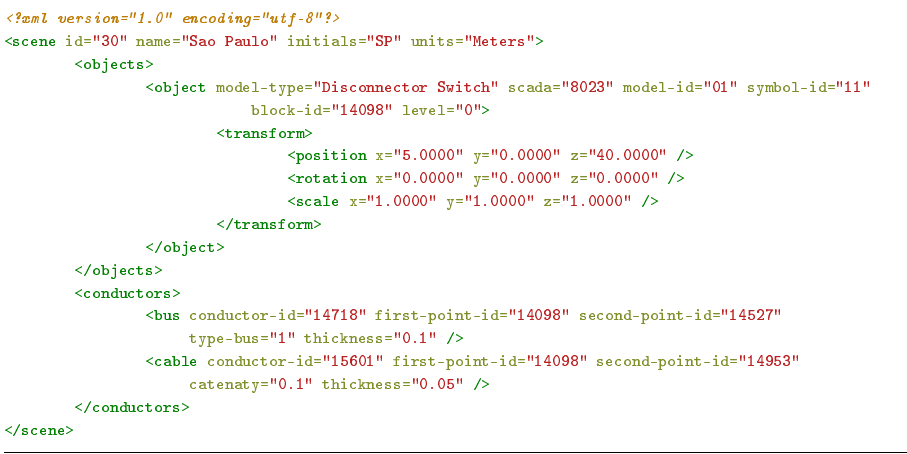
Figure 5. Conceptual diagram of the floor plans integration process between CAD Editor and Virtual Reality Software.